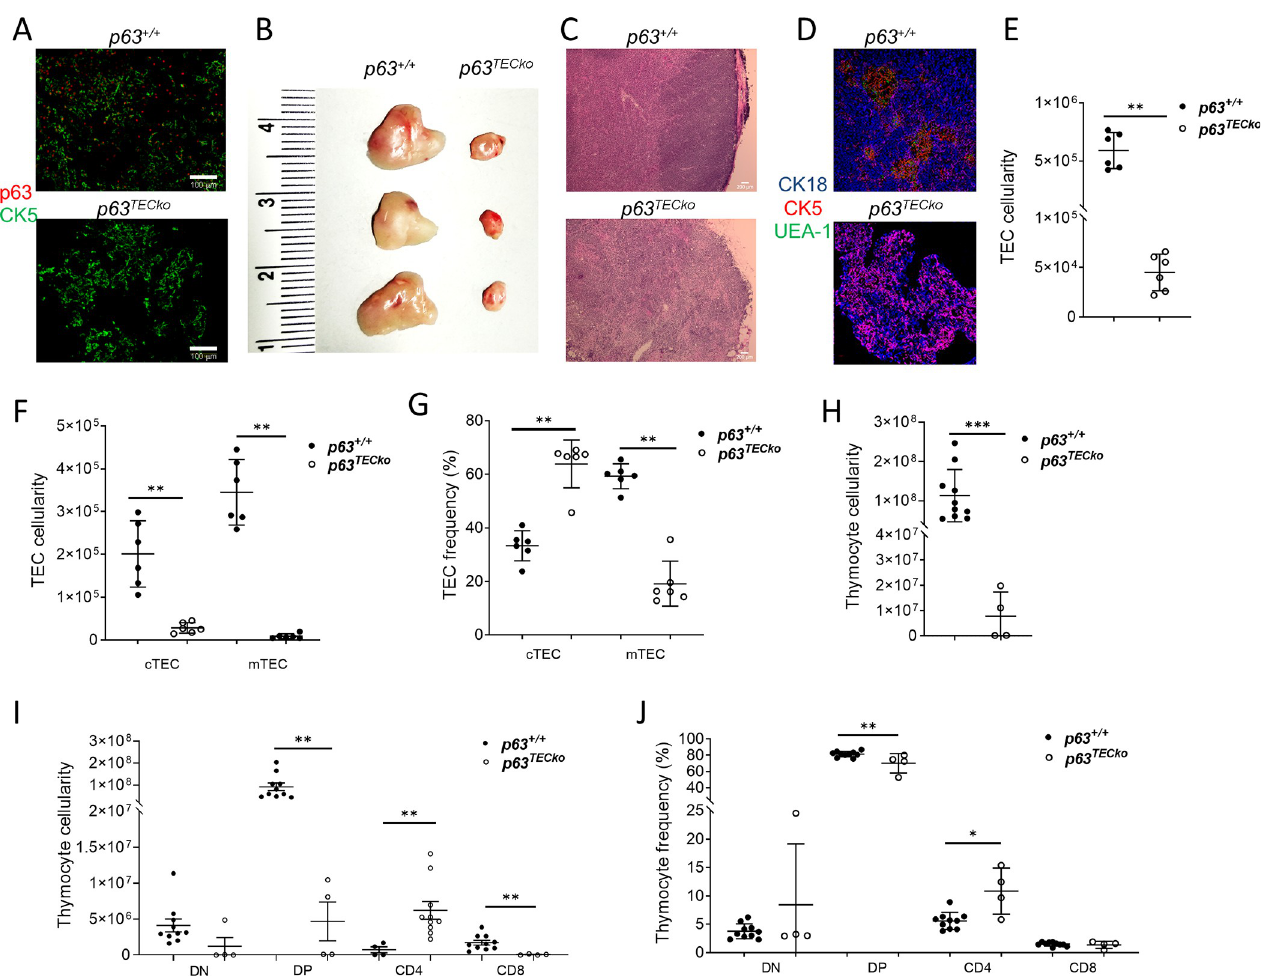
Fig 1. p63 TECko mice have profound thymic hypoplasia. Fig 1A shows absence of p63 in p63 TECko TECs. Fig 1B shows the thymus size of both p63 +/+ and p63 TECko adult mice. Fig 1C shows H and E staining. The scale bars are 50 μ m. Fig 1D shows CK18 (blue), CK5 (red) and UEA-1 (green) staining. Absolute numbers of TEC (1E and p = 0.0022), of TEC subsets (1F; cTEC, p = 0.0022; mTEC, p = 0.0022) and frequency of TEC subsets (1G; cTEC, p = 0.0022; mTEC, p = 0.0022) based on (CD45 − EpCAM + of cTECs (Ly51 + UEA − 1 - ) and mTECs (Ly51 - UEA-1 + I-A b+ ) are shown. Flow cytometric analysis for the cell-surface expression of CD4 and CD8 on thymocytes isolated from p63 TECko and littermate control mice. Numbers denote absolute number of cells of total thymocytes (1H; p = 0.0022) and subsets (1I; DP, p = 0.0011; CD4, p = 0.0077; CD8, p = 0.0022), and frequency of the subtypes (1J; DP, p = 0.0077; CD4, p = 0.0297). P values are